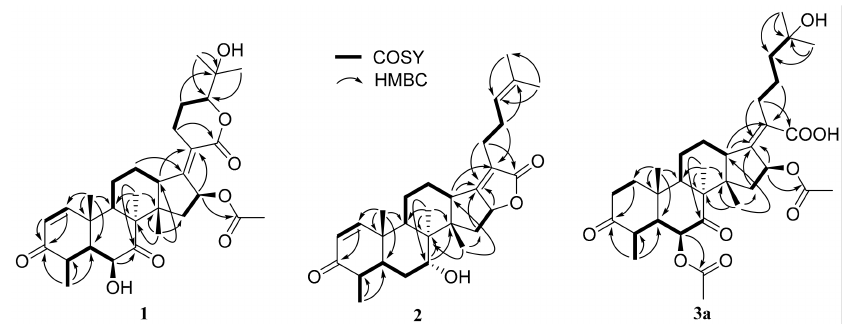
Figure 2. The key COSY (bold lines) and HMBC (arrows) correlations of compounds 1 , 2 and 3a .